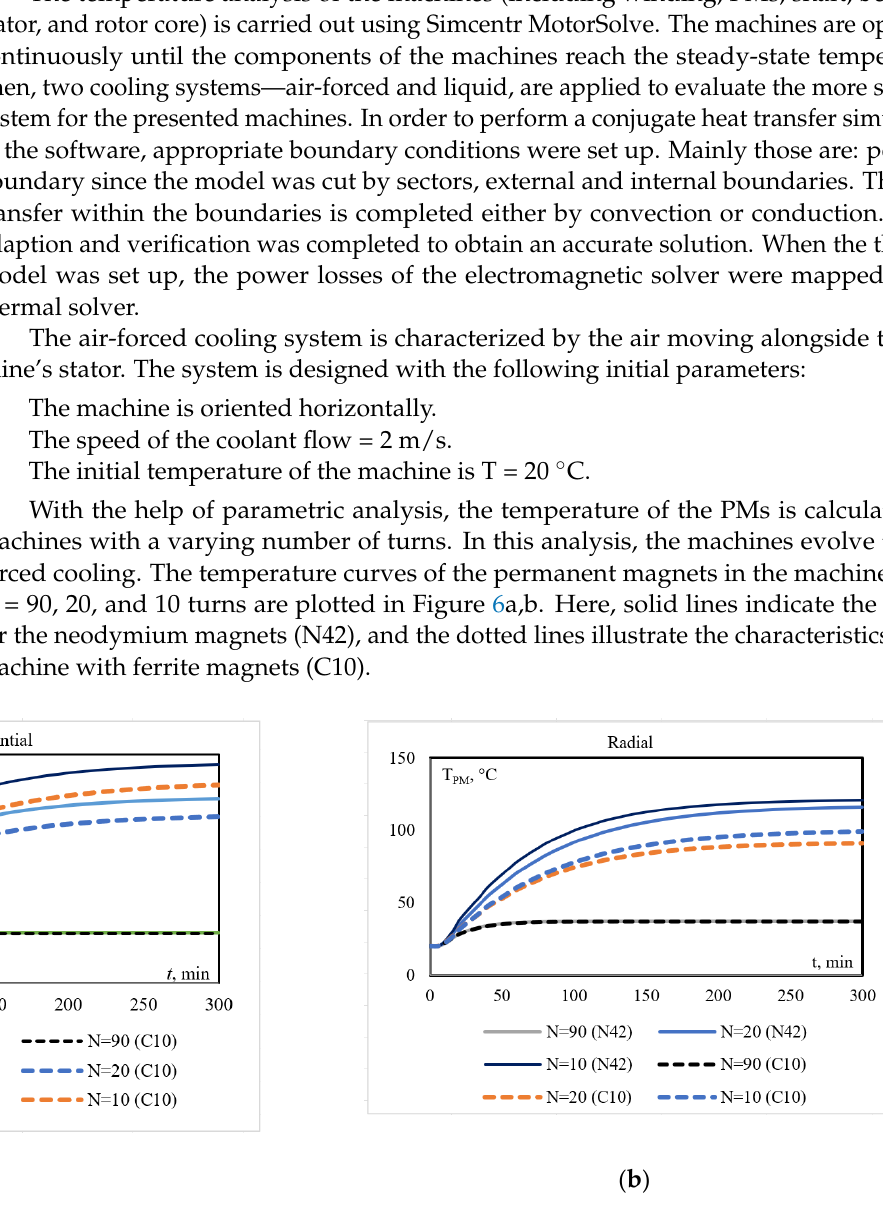
Figure 6. Temperature characteristics of the PMs in the tangential and radial machines with various numbers of turns at air-forced cooling. Here, the X -axis defines the time and the Y -axis shows the temperature of the machines.